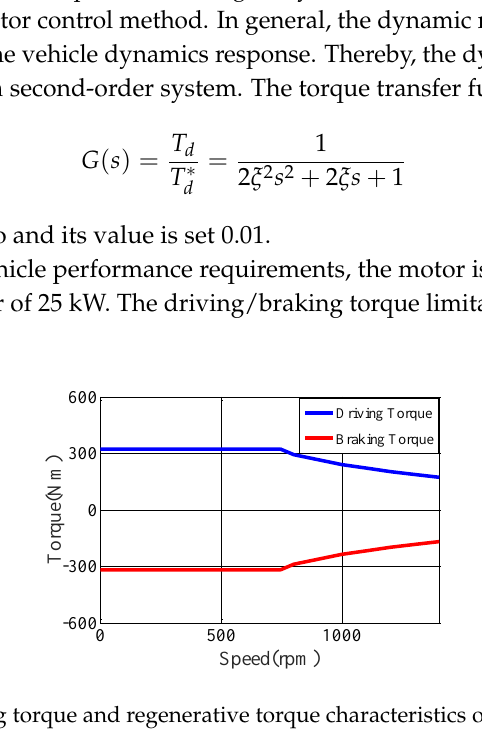
Figure 3. Driving torque and regenerative torque characteristics of in-wheel motor.